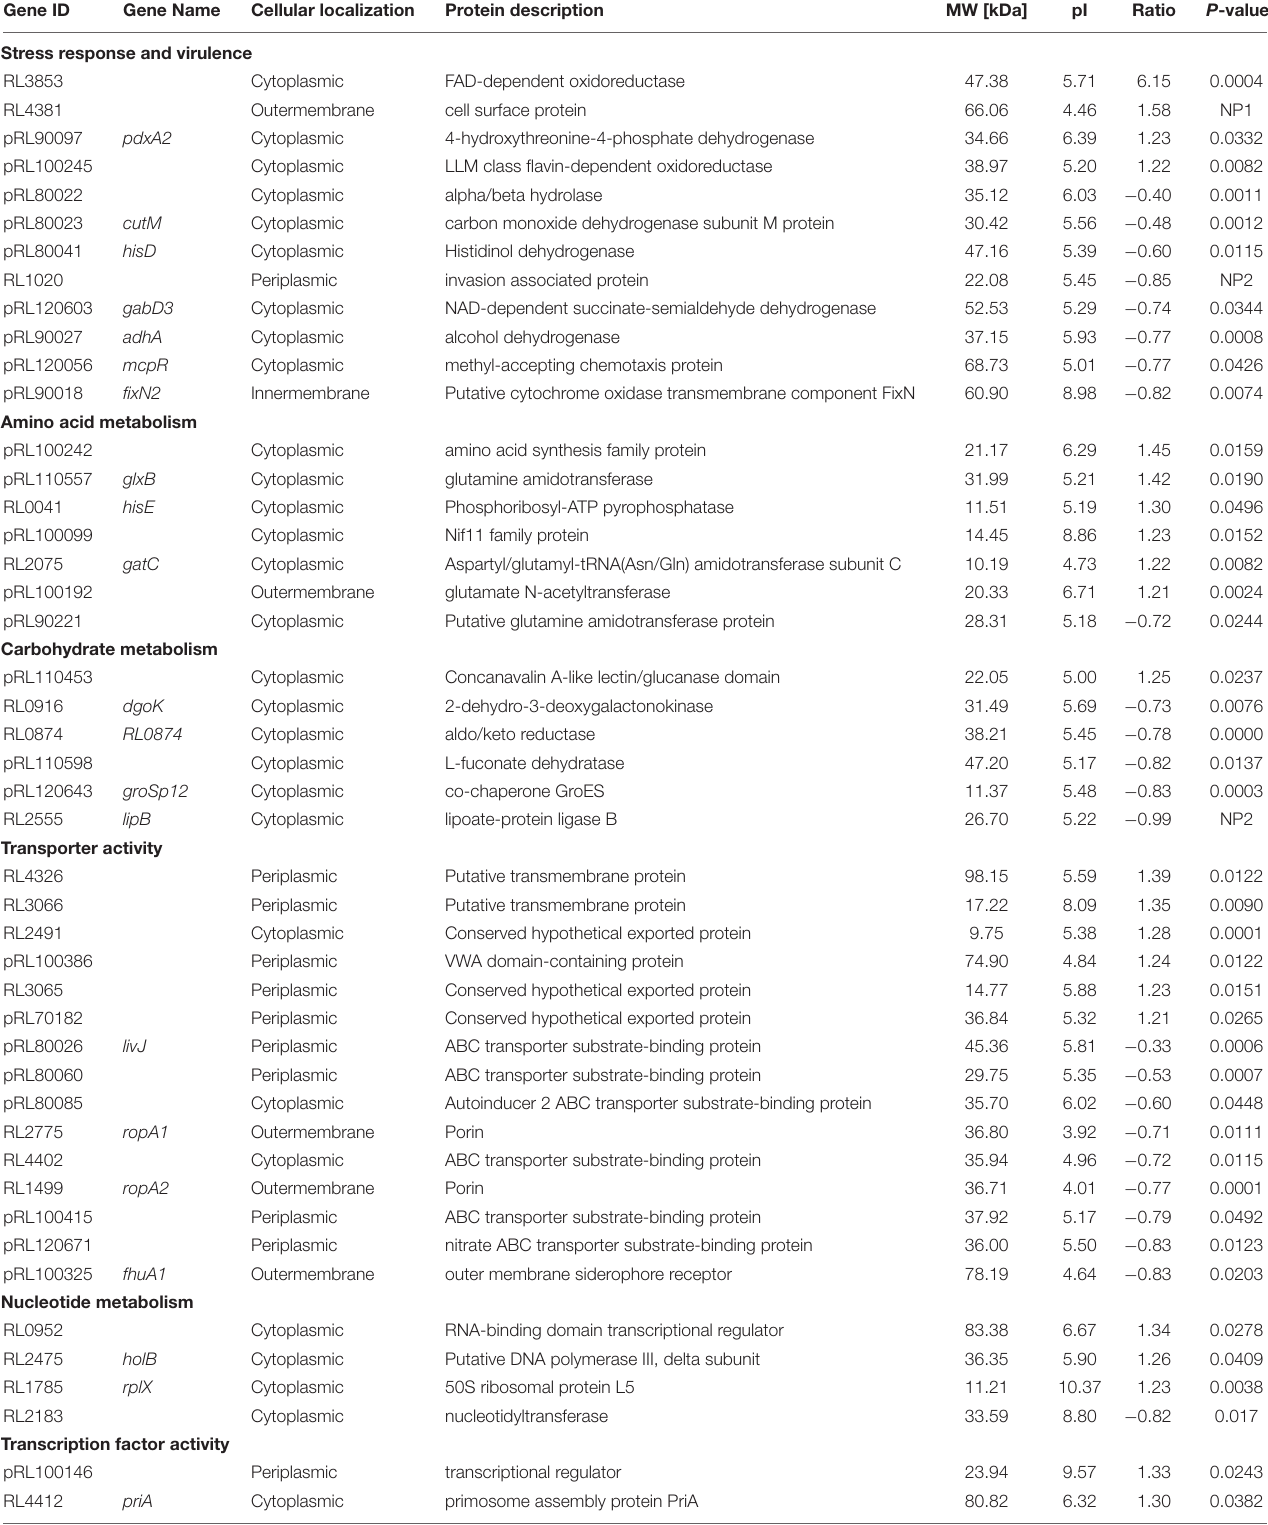
TABLE 5 | Differential expression proteins in 4-week nodule mutant bacteroids relative to wild-type